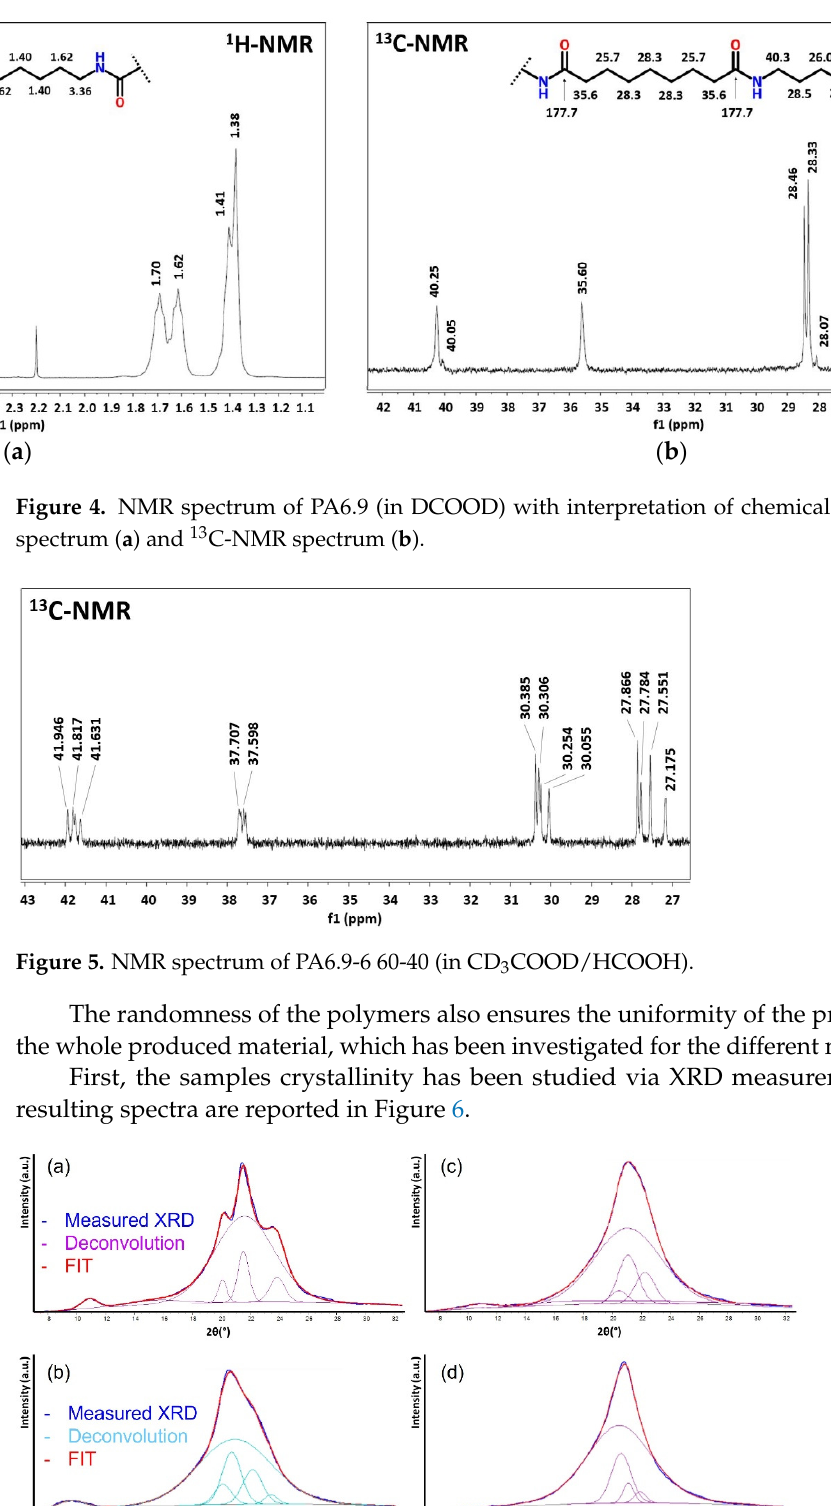
Figure 6. XRD spectra with deconvolution of the different crystalline and amorphous phases for PA6 ( a ), PA6.9 ( b ), PA 6.9-6 80-20 ( c ), PA6.9-6 60-40 ( d ). The measured crystallinity, considered as the ratio of the crystalline phases with respect to the whole area (given by the sum of amorphous and crystalline phases) is 32% for PA6, 31% for PA6.9, 24% for PA6.9-6 80-20 and 22% for PA6.9-6 60-40. As expected, the copolymer shows a decrease in the crystallinity, as can be easily deduced also considering the high transparency of the copolymer samples. In addition, looking at the